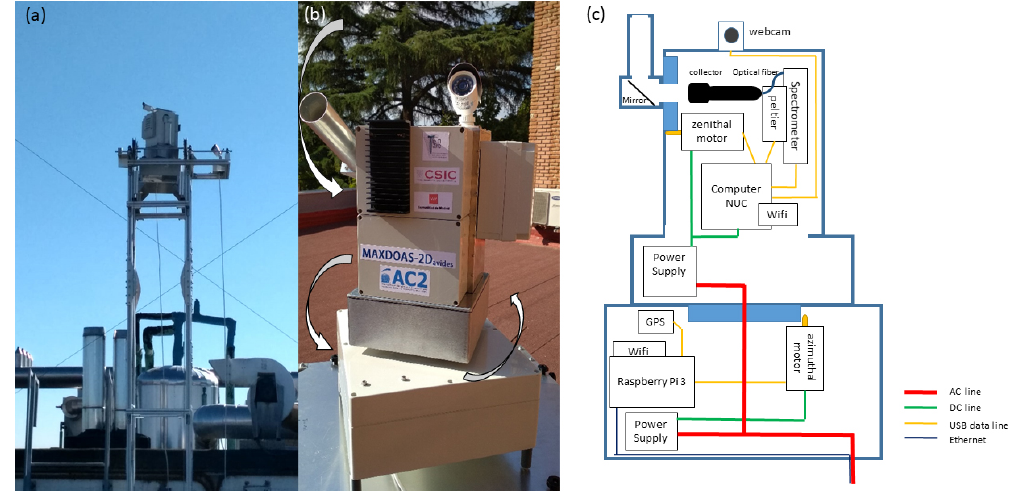
Figure 2. (a) Aluminum tower with the instrument installed on top of it; (b) MAXDOAS-2D instrument; (c) MAXDOAS-2D